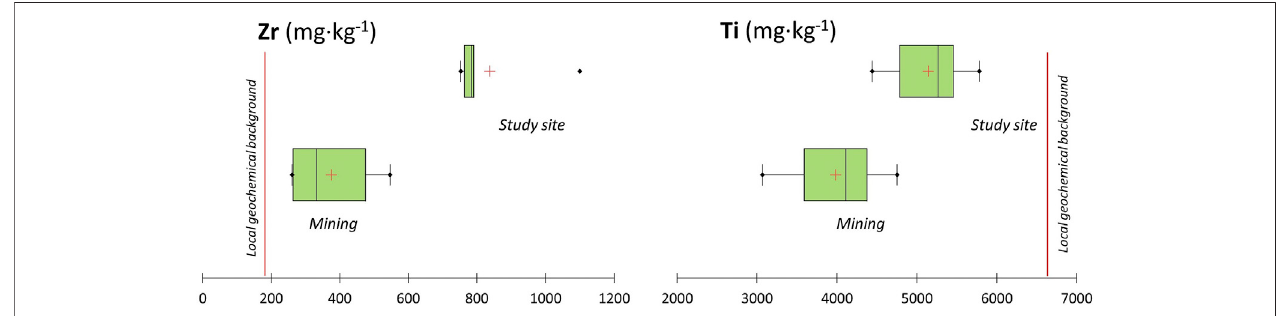
FIGURE 2 | Comparison of Ti and Zr contents in sediments from the study site of Bacochi (where amphibians were collected) and the mining area. Local geochemical background is shown for reference as the red dotted line (after Calmus et al., 2018). The box plots show the average, maximum, minimum, and median values (red cross) for each metal in the < 20 µm fraction of sediments of our